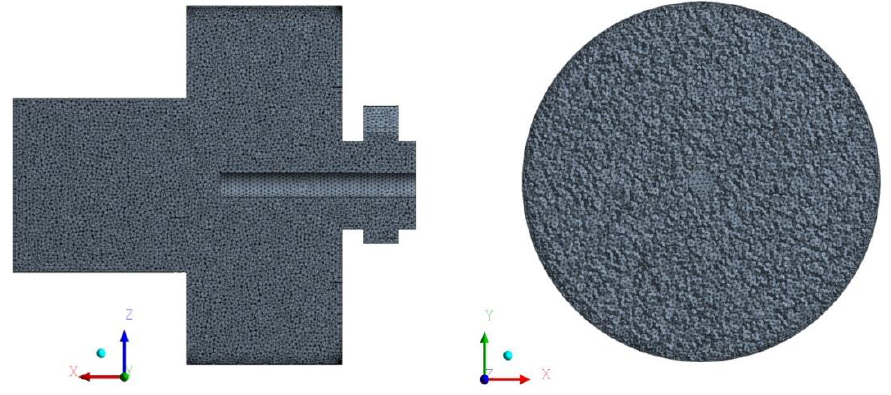
Figure 3. Computational mesh: ( left ) cross-sectional view in the X-Z plane, and ( right ) cross-sectional view in X-Y.